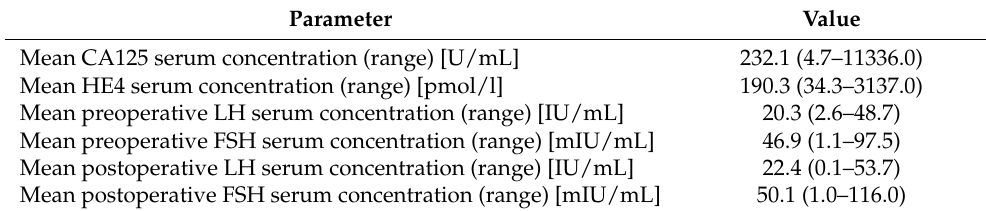
Table 2. Laboratory results of 92 endometrial cancer patients included in the study. CA125: cancer antigen 125; HE4: human epididymis protein 4; LH: luteinizing hormone; FSH: follicle- stimulating